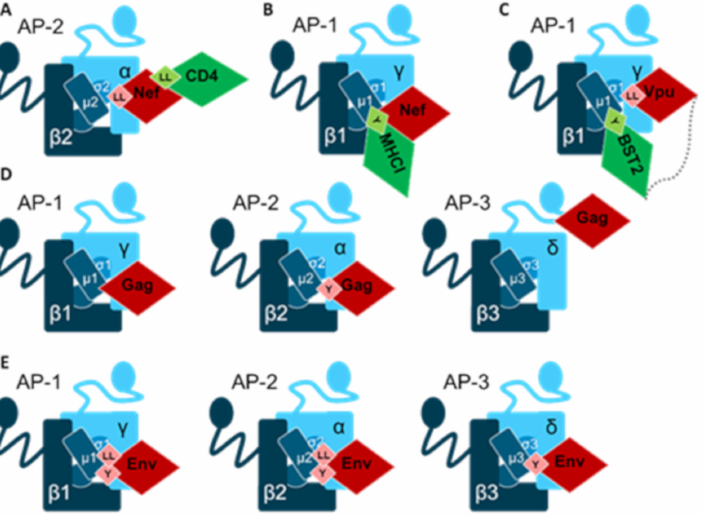
Figure 3. HIV-1 virus proteins (Nef, Vpu, Gag and Env) and their documented interactions with adaptins. Nef was shown to interact with AP-2 ( A ) and AP-1 ( B ), Vpu with AP-1 ( C ), while Gag ( D ) and Env ( E ) can interact with AP-1, 2 and 3. In case the motif participating in the interaction is known it is indicated (Y for tyrosine and LL for dileucine motif). Adaptins are shown in blue, HIV proteins in red, and molecules targeted by viral proteins are shown in green. Other molecules affected by HIV-1 are listed in the